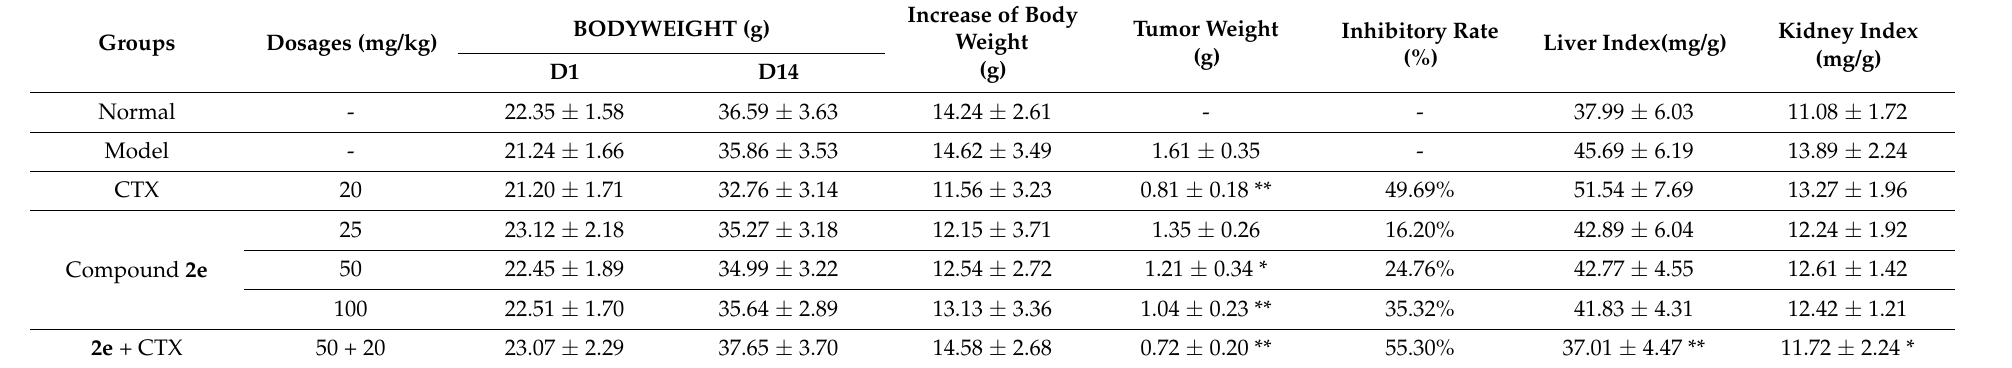
Table 2. Effects on body weight, tumor weight and organ